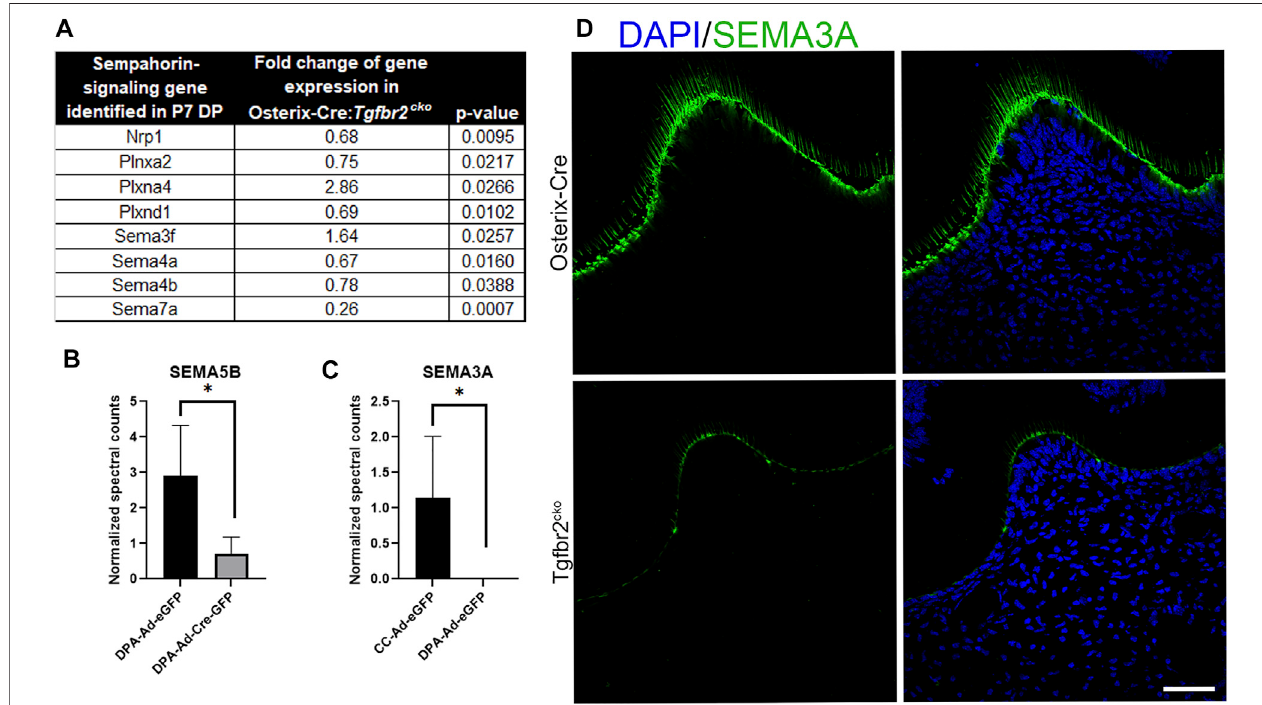
FIGURE7| Tgfbr2 deletioninDPcellsalterssemaphorinsignaling. (A) RNASeqanalysisofP7M1tissueindicatesalteredsemaphorinsignalingcomponents. N =5 forOsterix-Creand Tgfbr2 cko samples. (B,C) Proteomicanalysisofco-culture (CC)anddentalpulpalone(DPA)media. (B) ProteomicsindicatesdecreasedSemaphorin 5B present in the media with Tgfbr2 deletion in the DPCs. (C) Proteomics indicates Semaphorin 3A is only present in CC media and not when dental pulp cells were cultured alone. N = 4 media collected and analyzed from experiments including: co-culture samples with and without Tgfbr2 deletion, DPA samples with and without Tgfbr2 deletion, and TG cells cultured alone. * p < 0.05 by unpaired t -test. (D) Immuno fl uorescence of SEMA3A (green) demonstrates reduced chemoattraction signals in the Tgfbr2 cko odontoblasts compared to controls. N = 4 for Osterix-Cre and 4 Tgfbr2 cko samples. The scale bar is 50 μ m.